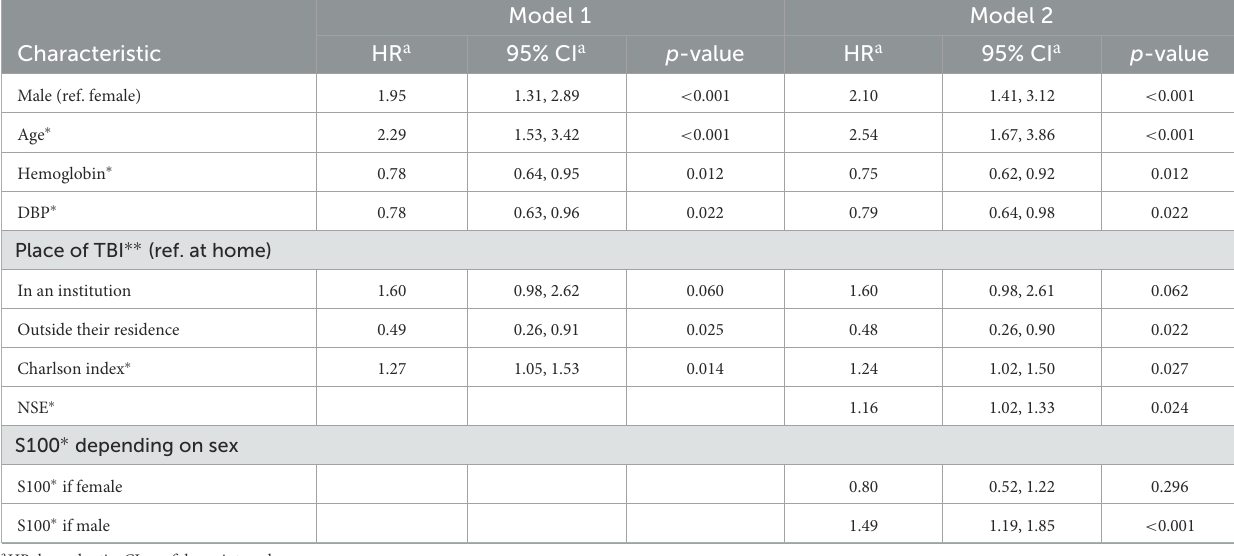
TABLE 2 Cox proportional hazards model 1 (without biomarkers) and model 2 (with significant biomarkers, NSE and